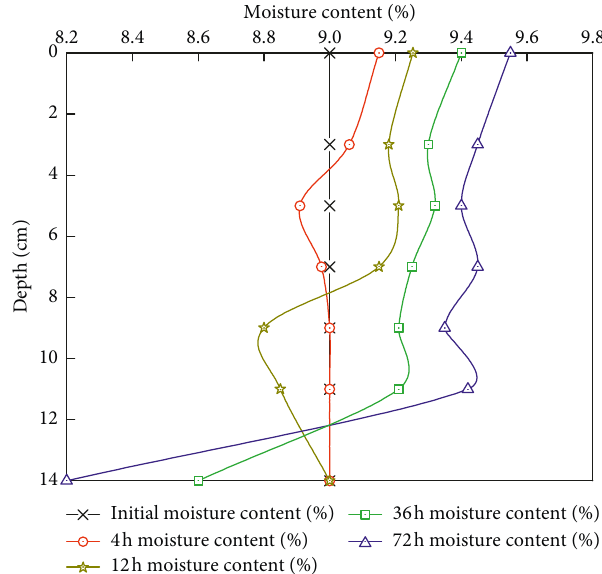
Figure 12: Moisture content distribution in soil after freezing of different